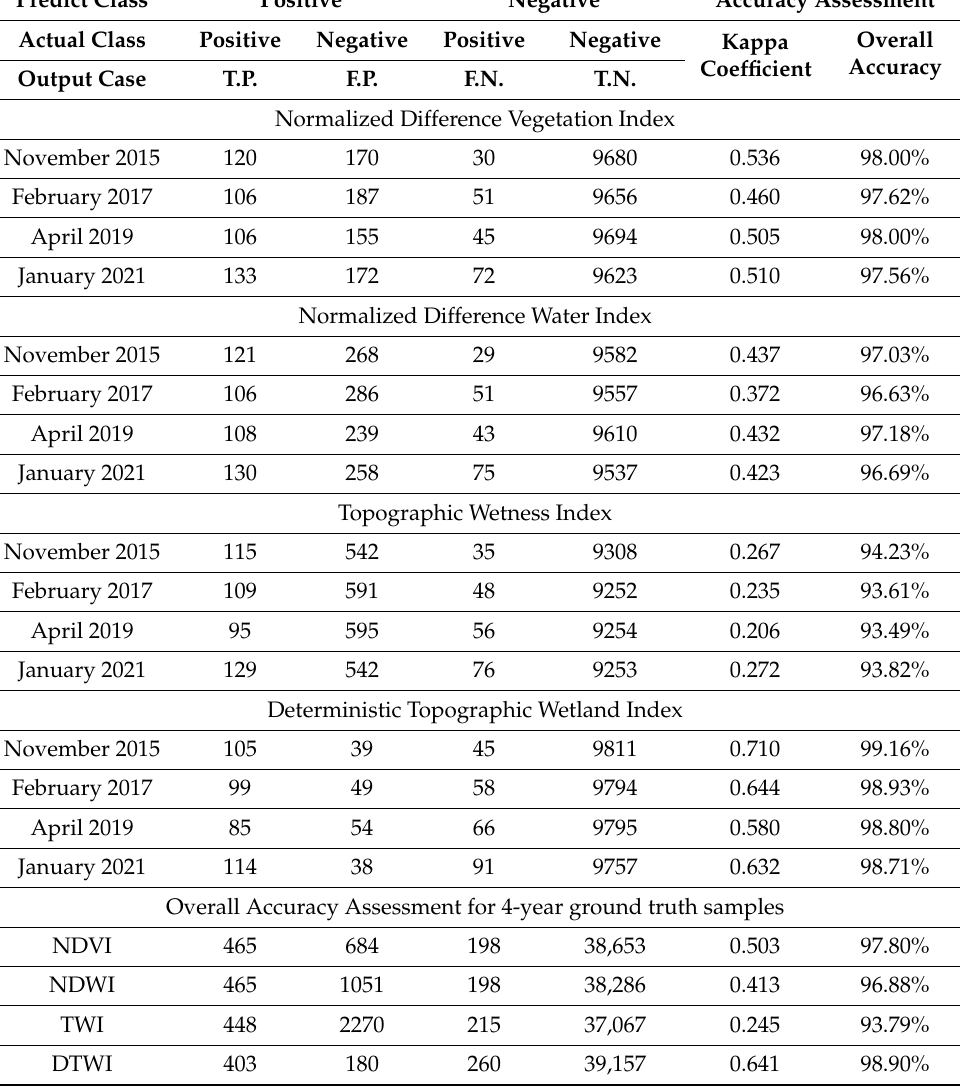
Table 3. The confusion matrices and the accuracy